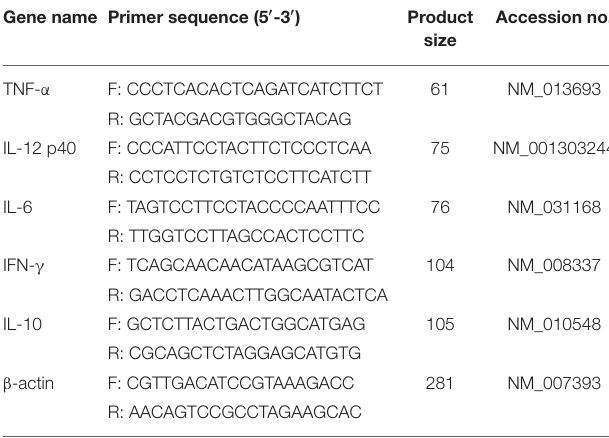
TABLE 1 | Primer sequences used for